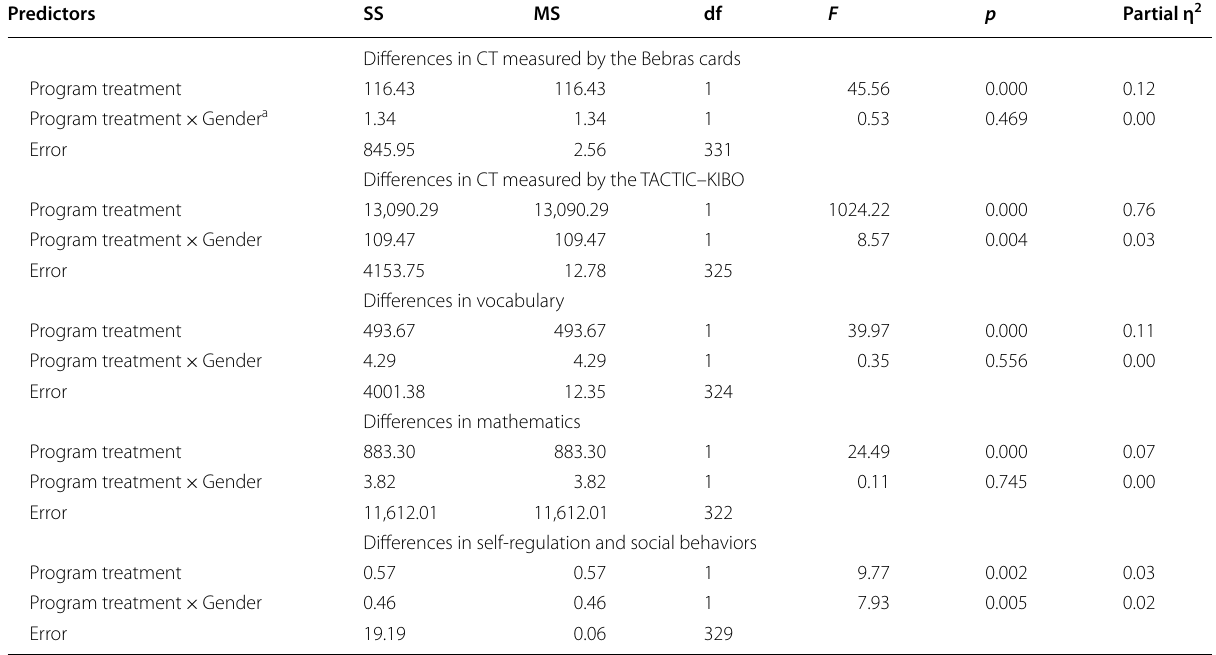
ANOVA analysis of variance, SS sum of squares, MS mean squares, CT computational thinking. a Boy